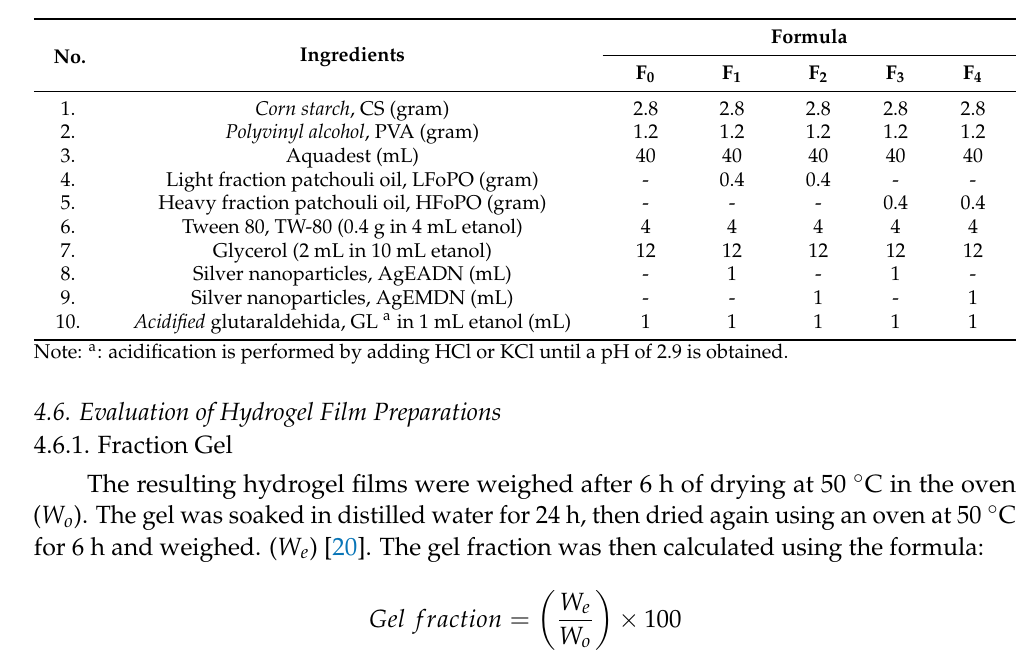
Table 10. Formulation of Polyvinyl alcohol/Corn starch/Patchouli oil Hydrogel Films loaded with Silver Nanoparticles (PVA/CS/PO/AgNPs)